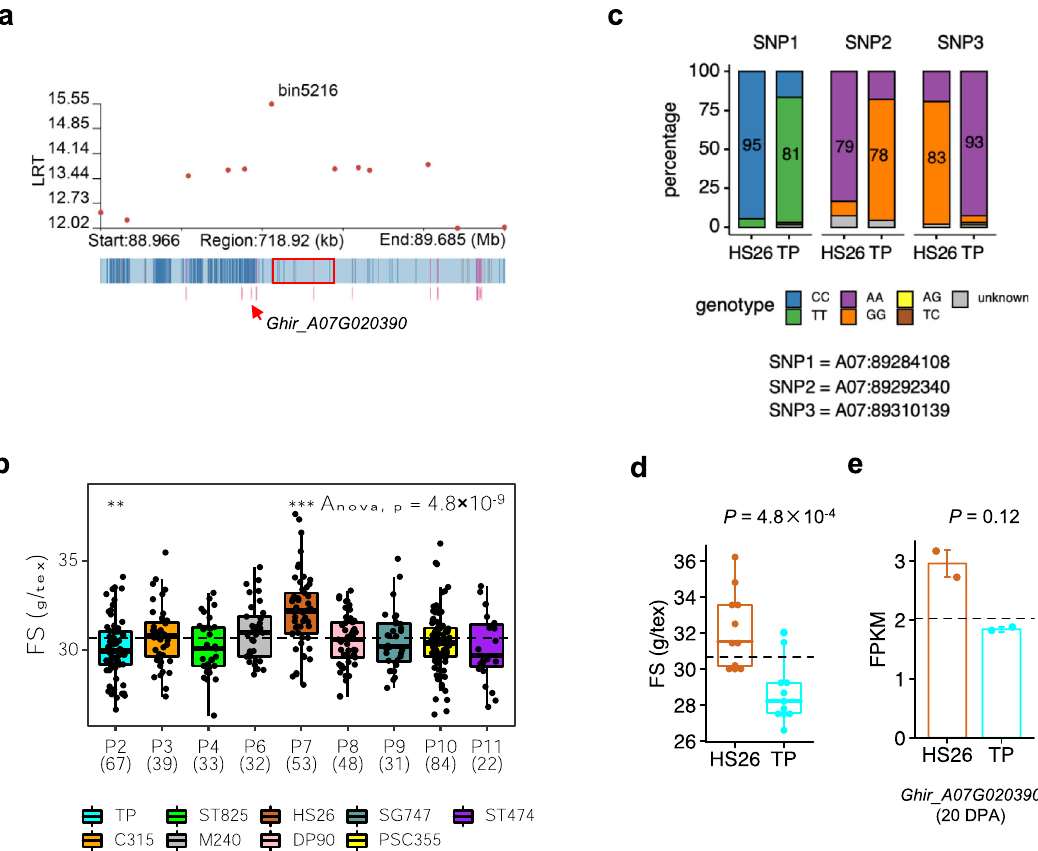
Fig. 4 Inference of functional allelic types across parent IBD groups for FS on chromosome A07 (88.97-89.69 Mb) and identi fi cation of the candidate genes. a Dot plot of hGWAS result for FS (top) and SNP distribution (bottom) surrounding the peak on chromosome A07. Red box indicates the position of the most signi fi cant bin. Arrow indicates the position of candidate gene Ghir_A07G020390 . b Boxplots for FS based on the different parent IBD groups ( P ) ( n > 3). Parent IBD group was de fi ned by the different status of bin5216. Dashed line indicates the mean value of FS in all RILs. ANOVA ( P = 4.8 × 10 − 9 ) shows that the mean values of different parent IBD groups are not equal. Differences between RILs of a single parent IBD group and all RILs were analyzed by a two-tailed Student ’ s t -test (*** P < 0.001; ** P < 0.1). The numbers in parentheses are the MAGIC RIL counts in each parent IBD group. c Percentage of different genotypes of 3 SNPs located in bin5216 in HS26 and TP. d FS of parent HS26 and TP. P -value was calculated by Student ’ s t -test. Error bars, standard error. e Expression of gene Ghir_A07G020390 in parent HS26 and TP at the cell-wall-thickening stage (20 DPA) of fi ber development. P- value was calculated by a two-tailed Student ’ s t -test. Error bars, standard